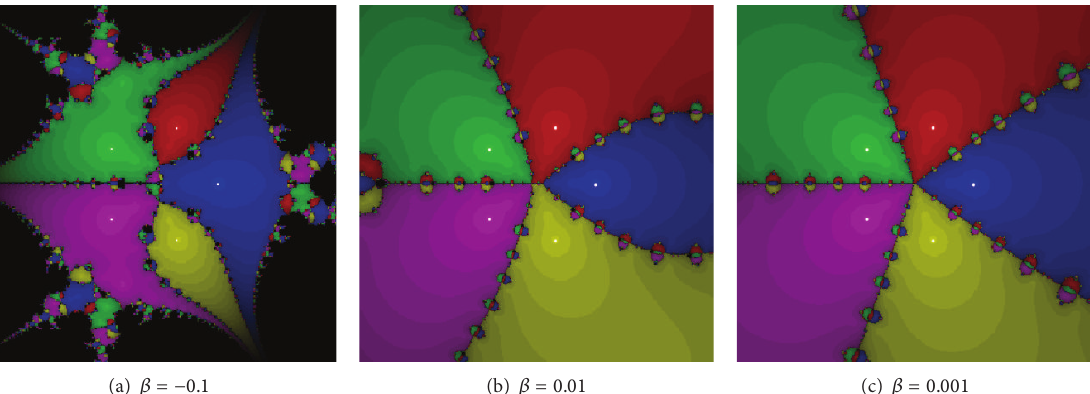
Figure 6: Scheme (3) for the test problem 3.